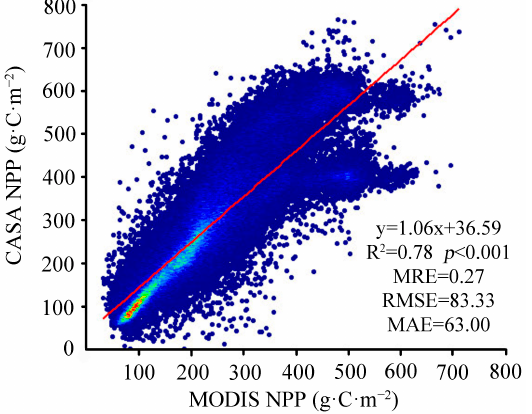
Figure 3. Comparison between the simulated NPP using the CASA model and MODIS NPP.